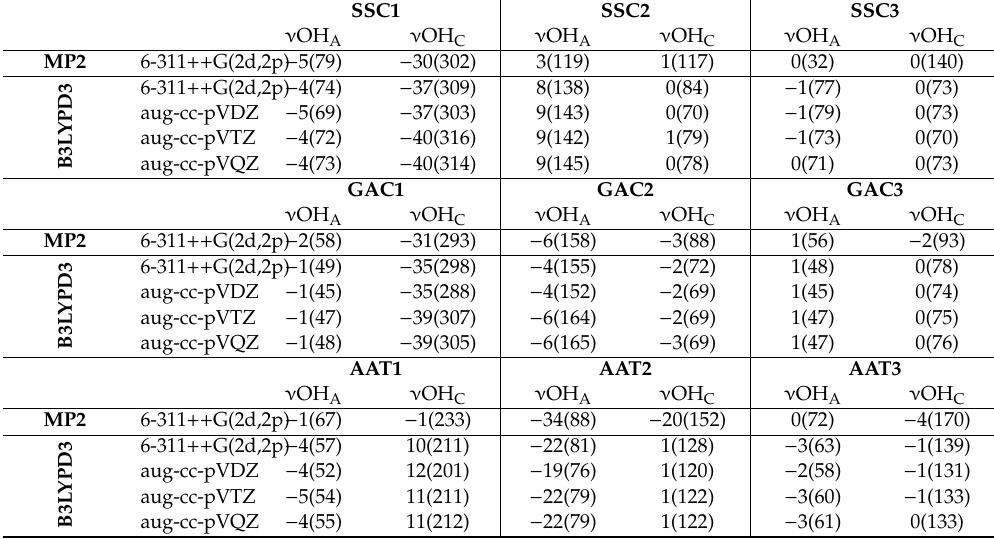
Table 2. The ν OH shifts (in cm − 1 ) and intensities (in km mol − 1 , given in parentheses) in GA complexes with nitrogen at di ff erent levels of